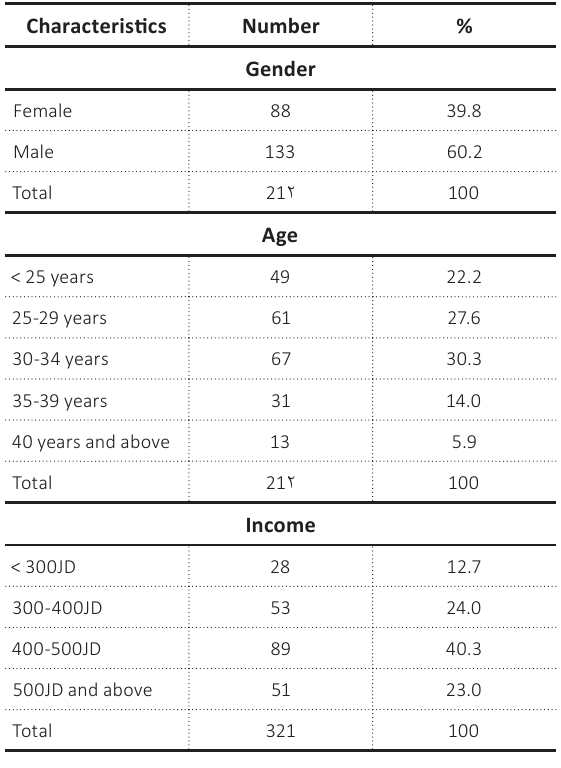
Table 2. Descriptive statistics, Pearson correlations, and reliability